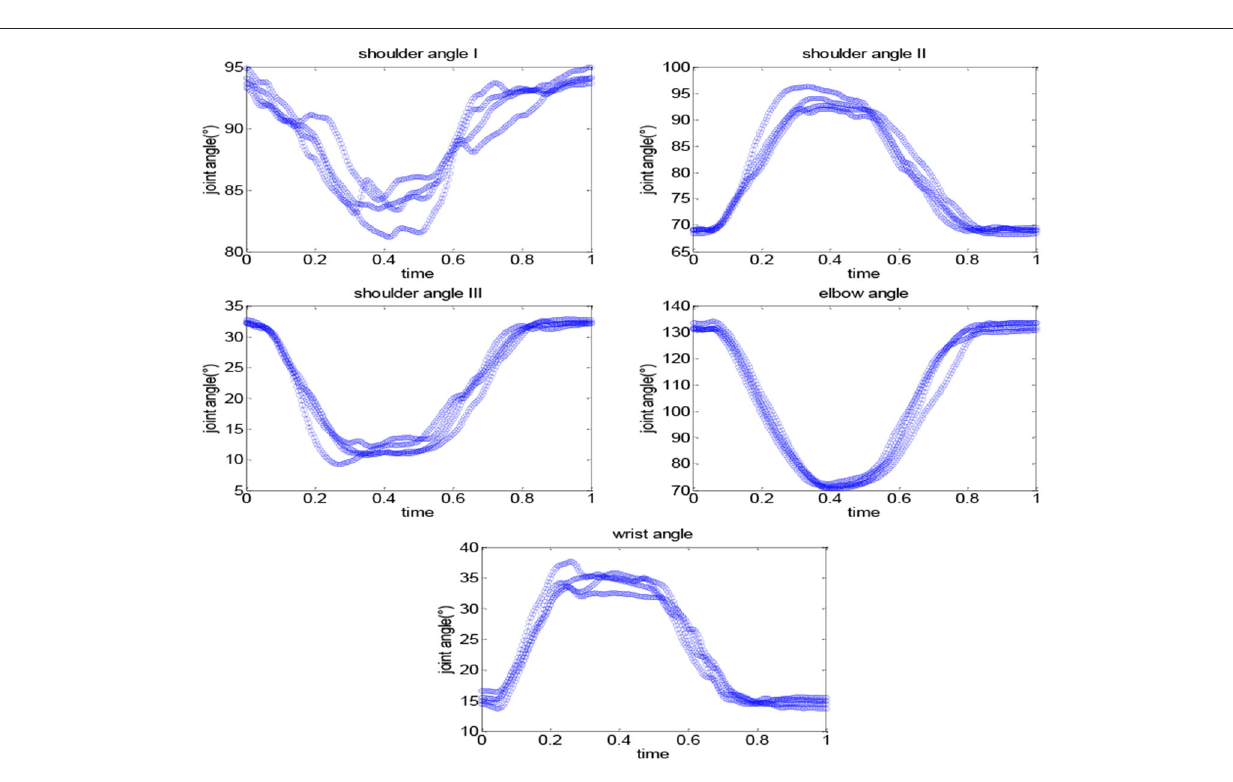
addition, the recorded paths can only suit certain tasks while the quantification model has potential for other